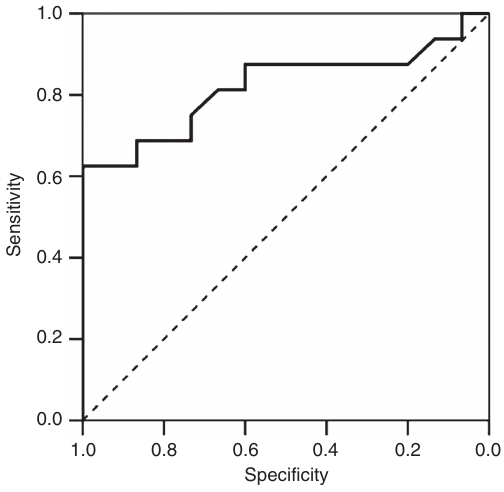
Figure 1: The receiver operating characteristics (ROC) curve of sali- vary neopterin in the diagnosis of oral cancer.